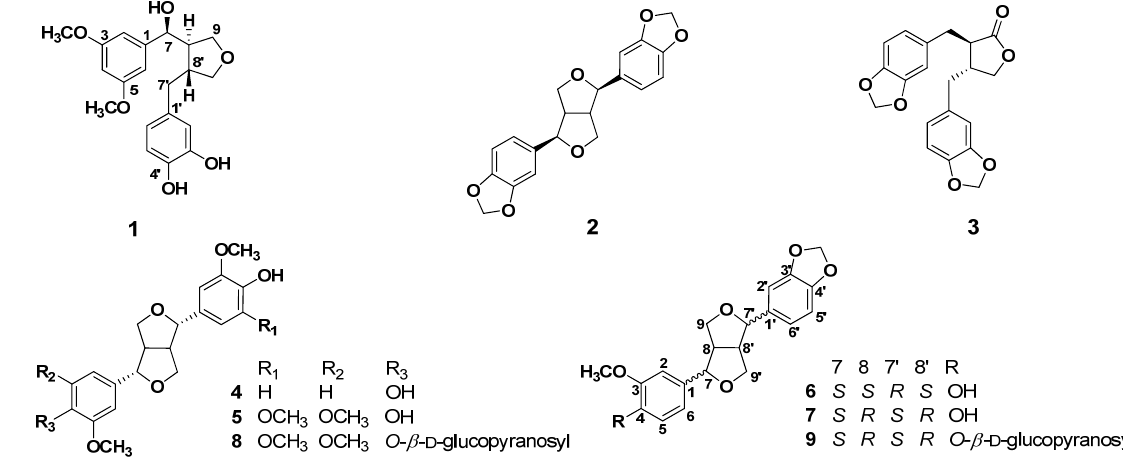
Figure 1. Chemical structures of isolated compounds 1  9